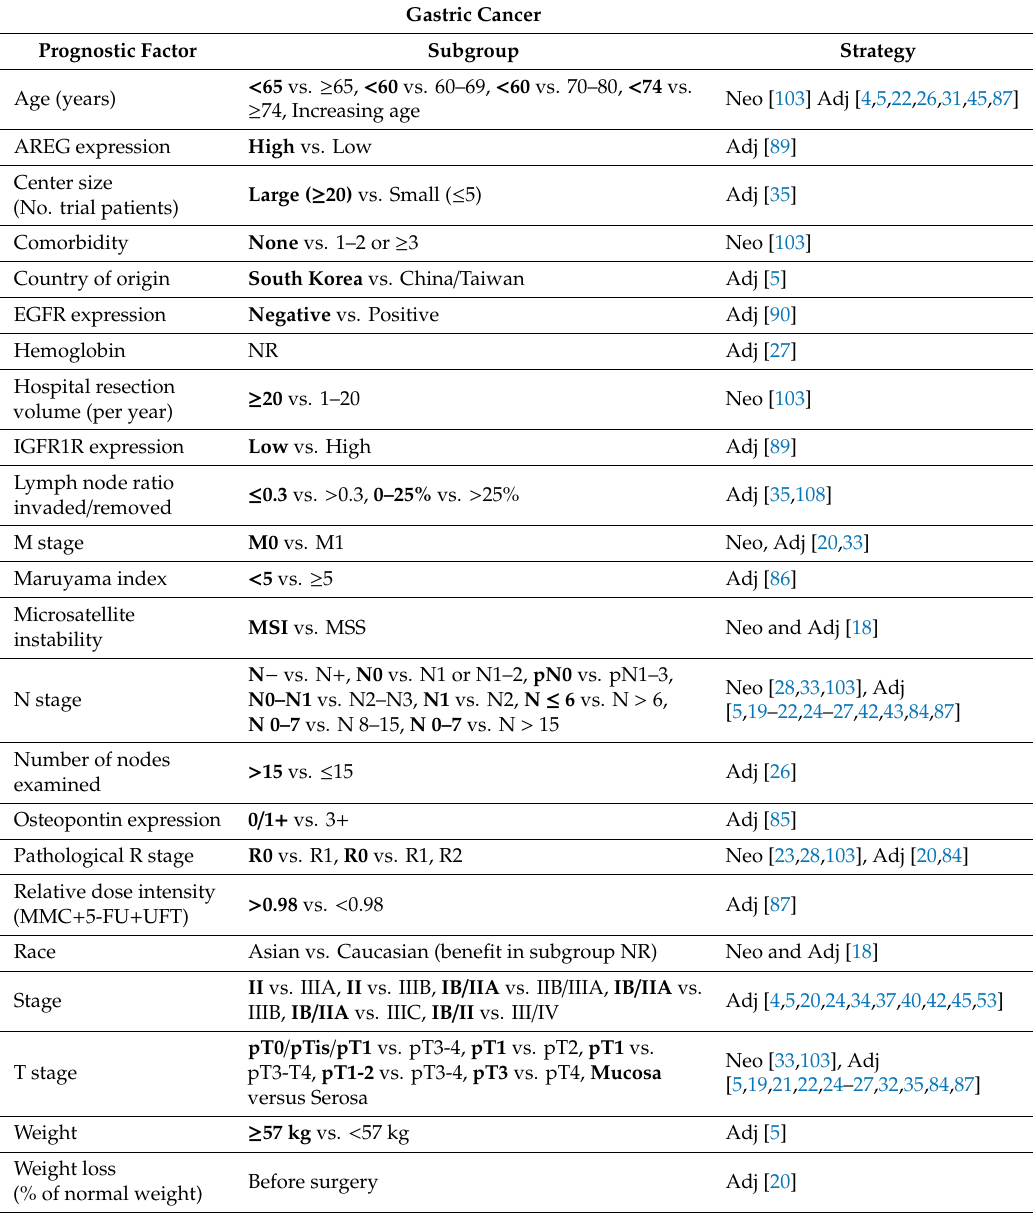
Table 1. Potentially clinically relevant prognostic factors identified from multivariate OS analyses for the curative treatment of gastric cancer. Highlighted are the subgroups which showed significant ( p < 0.05) survival benefit over the other subgroup for potentially clinically relevant prognostic factors, if it was possible to identify this from individual studies. Under strategy, the treatment setting of RCTs are listed for each prognostic factor. Metastases (factor: M stage) were discovered after surgery in